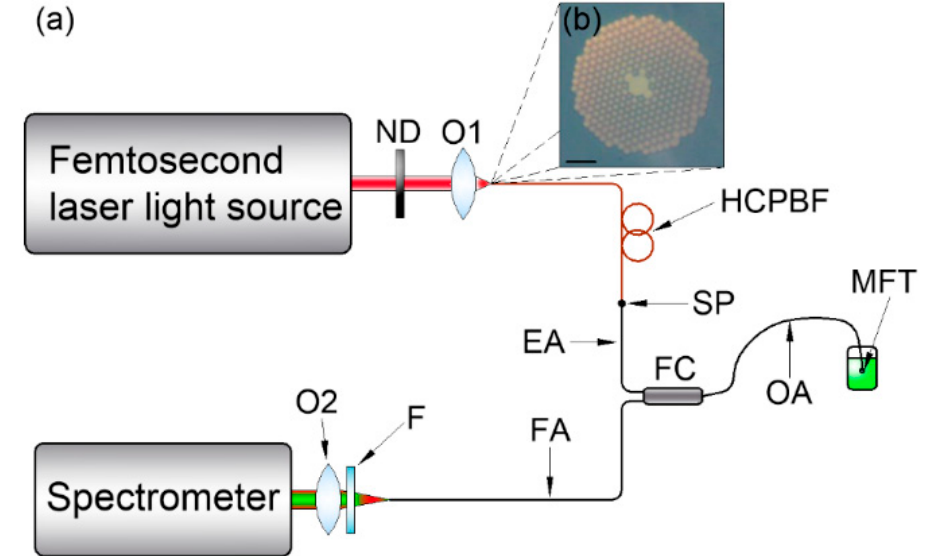
Figure 1. ( a ) Multiphoton fluorescence measurement setup schematic. ND: variable neutral density filter; O1, O2: 10X/0.24 microscope objectives; HCPBF: hollow-core photonic bandgap fiber; SP: